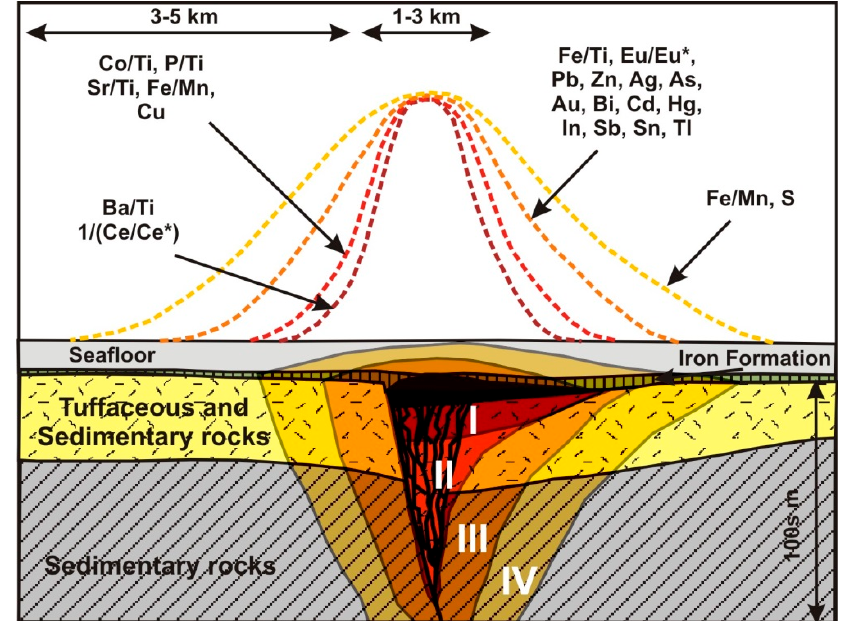
Figure 2. Schematic diagram illustrating the lateral extent of chemical haloes, forming different hydrothermal alteration zones surrounding the Brunswick No. 12 deposit, BMC (modified from [9]). See text for description of alteration zones I, II, III, and IV.